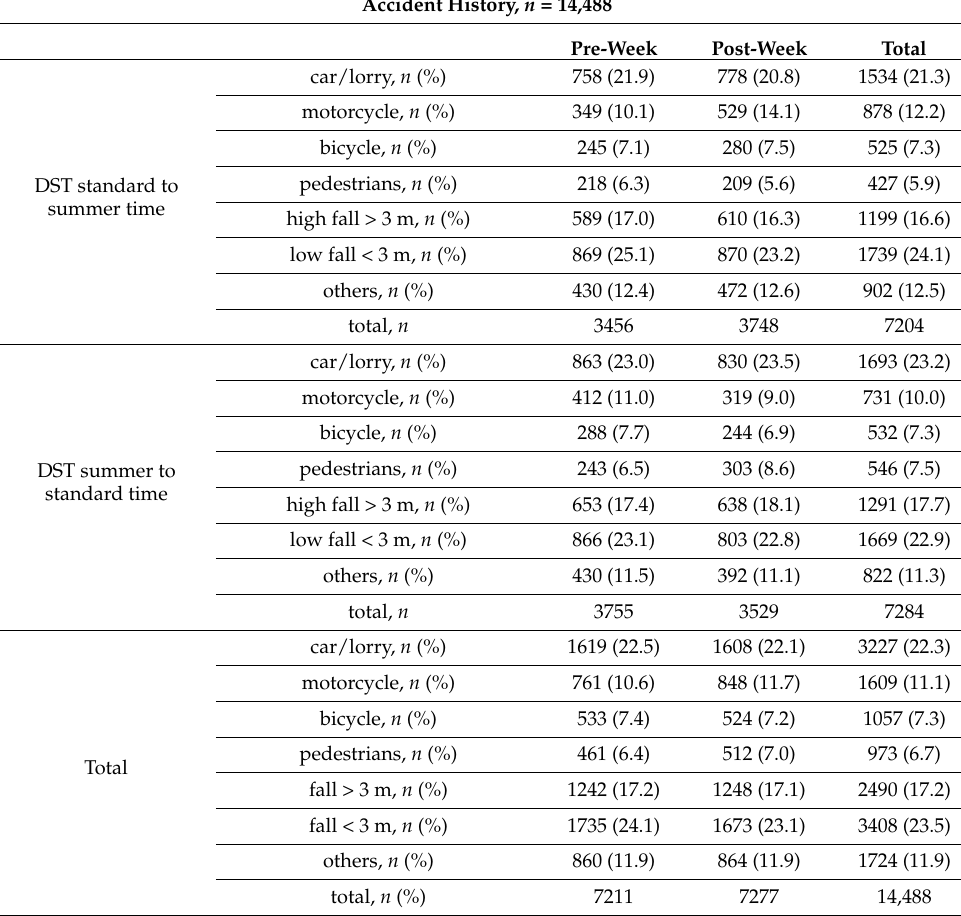
Table 1. Impact of daylight saving time change in patients with major